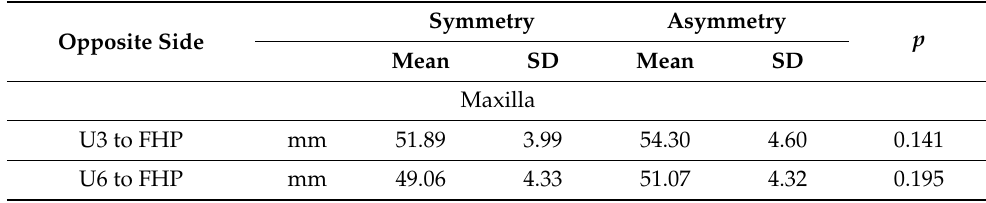
Table 6. Comparison of 3D preoperative (T0) measurements of bilateral variables between groups S and A (opposite